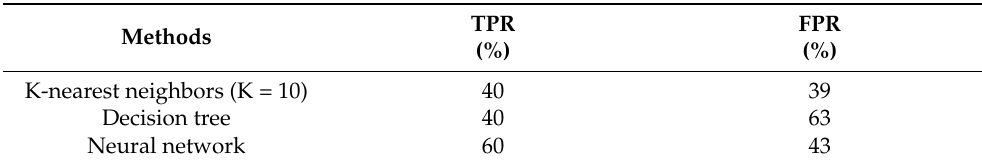
Table 10. Metric evaluation of the supervised methods.